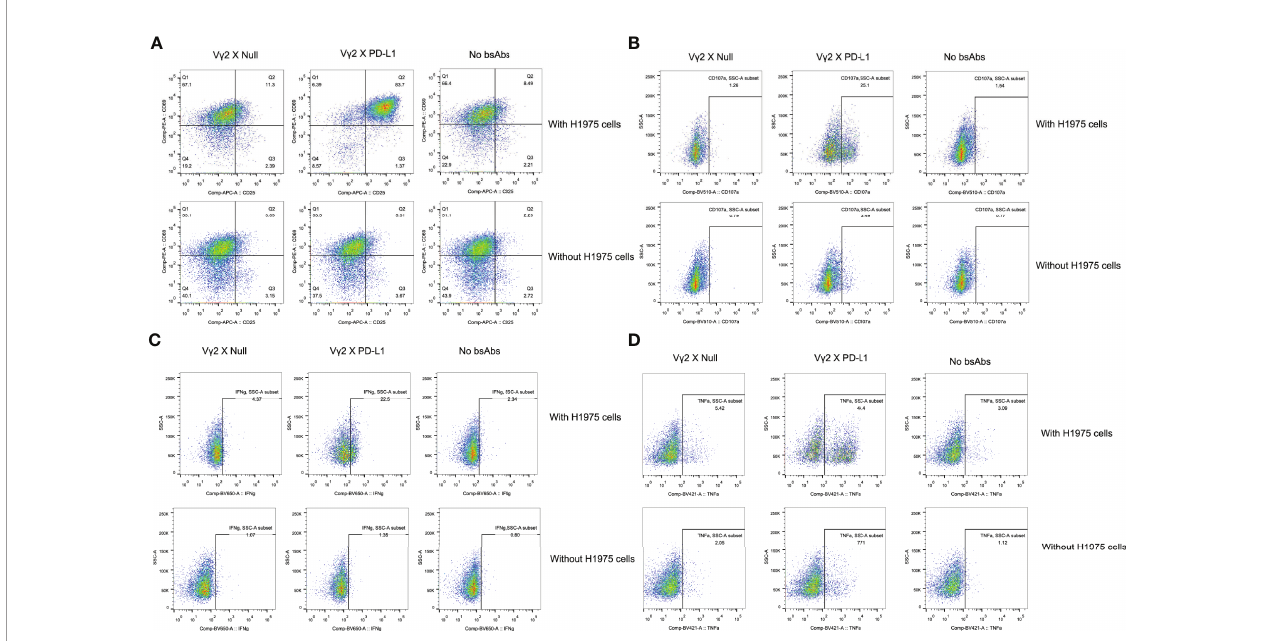
FIGURE 4 | Representative fl ow cytometry plots. The plots were showed for the activation (A) , TNFa and IFNg production (B, C) , and CD107a upregulation (D) of Vg2Vd2 T cells as under the indicated conditions.